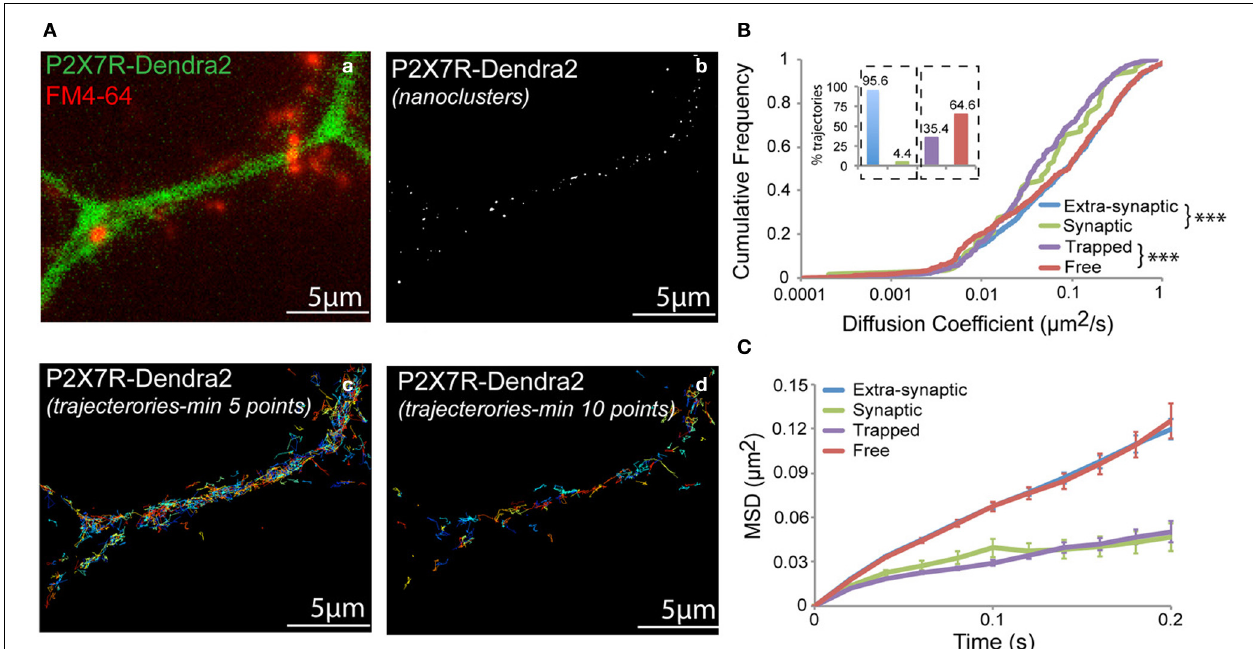
FIGURE 3 | sptPALM of P2X7-Dendra2 receptors. Live cell sptPALM was performed at 50Hz on dendrites expressing P2X7-Dendra2. (Aa) Epi-fluorescence of a P2X7-Dendra2 (green) expressing dendrite and FM4-64 (red) labeled synapses. FM4-64 was used for identification of “synaptic” and “extra-synaptic” trajectories. (Ab) Representative threshold image obtained from a super-resolved rendered image shows nanoclusters used for localization of trajectories. Trajectories were localized as “trapped” or “free” within nanoclusters. (Ac,Ad) Example of trajectories obtained using